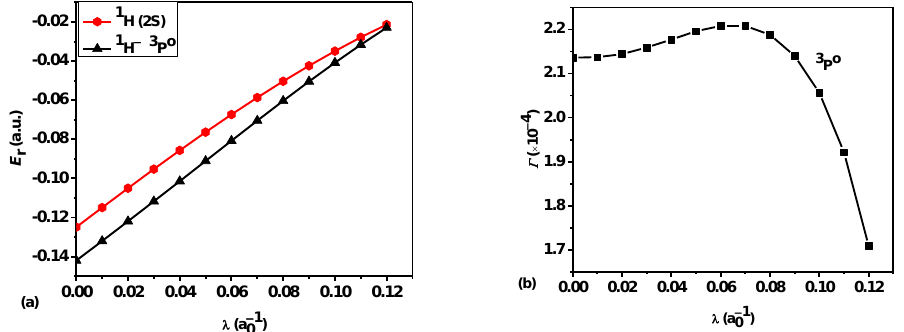
Figure 13. ( a ) Plot of the lowest 3 P o resonance energy 𝐸 𝑟 of 1 H − versus the screening parameter 𝜆 . ( b ) Plot of the corresponding resonance width 𝛤 of 1 H − versus 𝜆 .